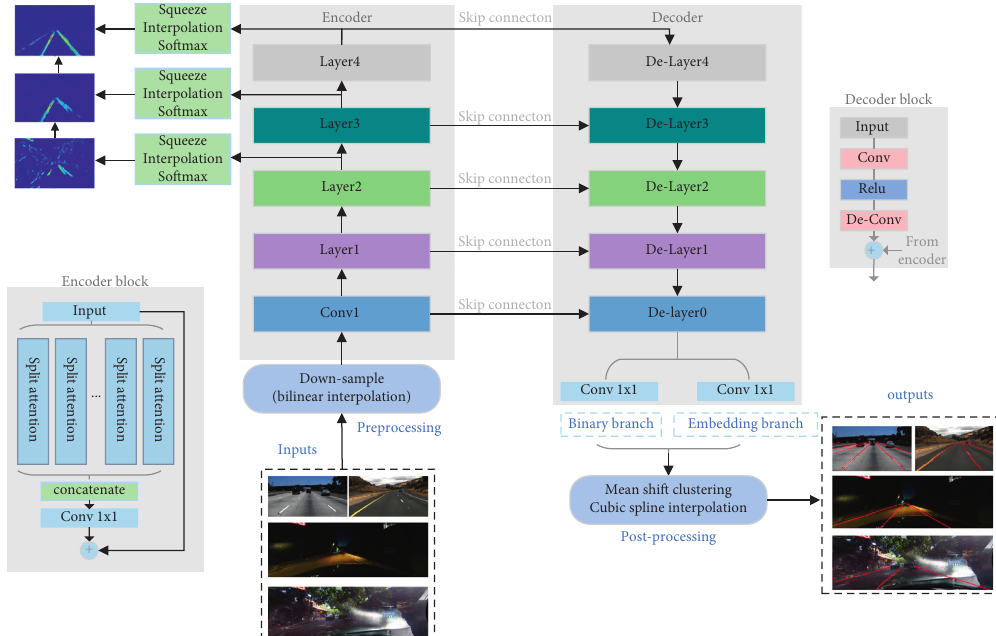
Figure 1: The flowchart of our method. Our network has one encoder, one decoder, and two branches. Through this network, images are segmented at the pixel level and the instance of each lane is obtained. Then, the cubic spline interpolation is used to fit each